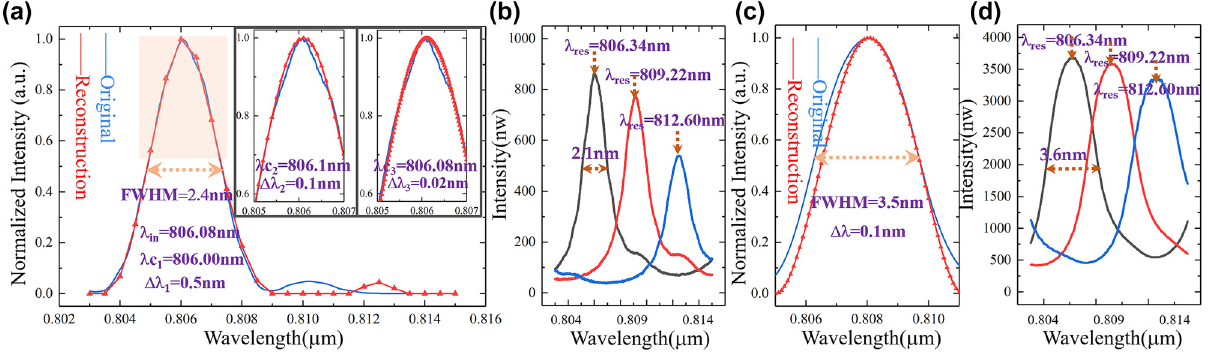
Figure 4: The reconstructed results of broadband spectrum with three micro-rings. (a) The reconstructed spectrum at different wavelength intervals = 806.08 nm and FWHM = 2.4 nm. (b) The system transmission spectra with FWHM of 2.1 nm. (c) The reconstructed spectrum with with 𝜆 in 𝜆 = 808.06 nm and FWHM = 3.5 nm. (d) The system transmission spectra with FWHM of 3.6 in